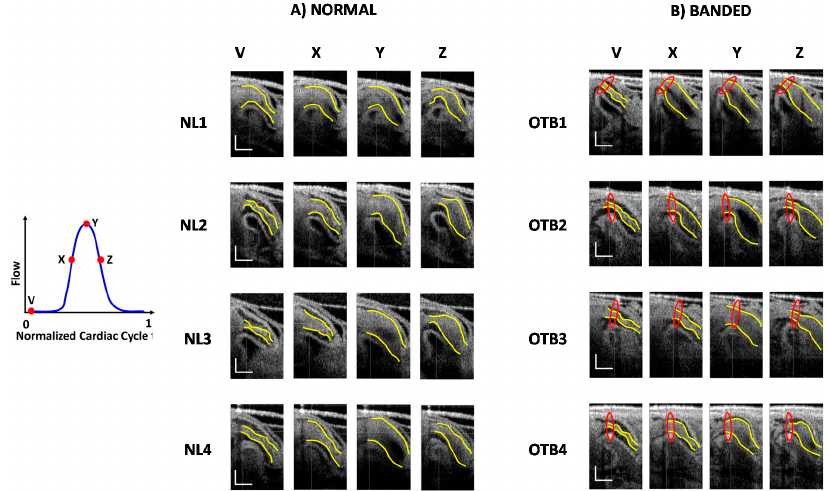
Figure 4. Longitudinal OCT images of the OFT at different phases during the cardiac cycle, with overlaid segmentations of the OFT lumen shown in yellow. The images compare the configurations of ( A ) four normal (NL); and ( B ) four banded (OTB) embryos. The images show the OFT configuration from close to the ventricle (left upper corner of the images) to near the aortic sac (right down corner of the images). Phases depicted (see also the flow schematics on the left) are: (V) closed OFT lumen; (X) midway opening; (Y) maximum flow, fully open configuration; and (Z) midway contraction, for each embryo. The location of the band is shown in red. Scale bars are 250 µm. The 4D wall motion of the OFT was visualized using 2D area plots (see Figure 5). The OFT wall has a peristaltic-like motion, with lumen cross-sections expanding and contracting sequentially